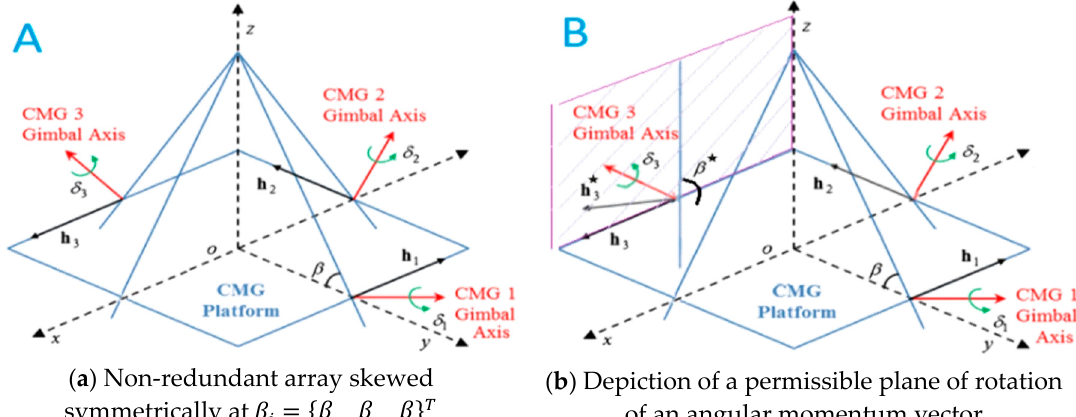
( b ) Depiction of a permissible plane of rotation of an angular momentum vector Figure 2. Spacecraft body axes serving as basis vectors in schematic drawings of skewed SGCMG array geometries, noting the angular momentum, torque, and gimbal vectors that define a right-hand set. . . (cid:80) T inertial = H inertial = H B + ω B × H B , a time-derivative (rate According to Euler’s equation